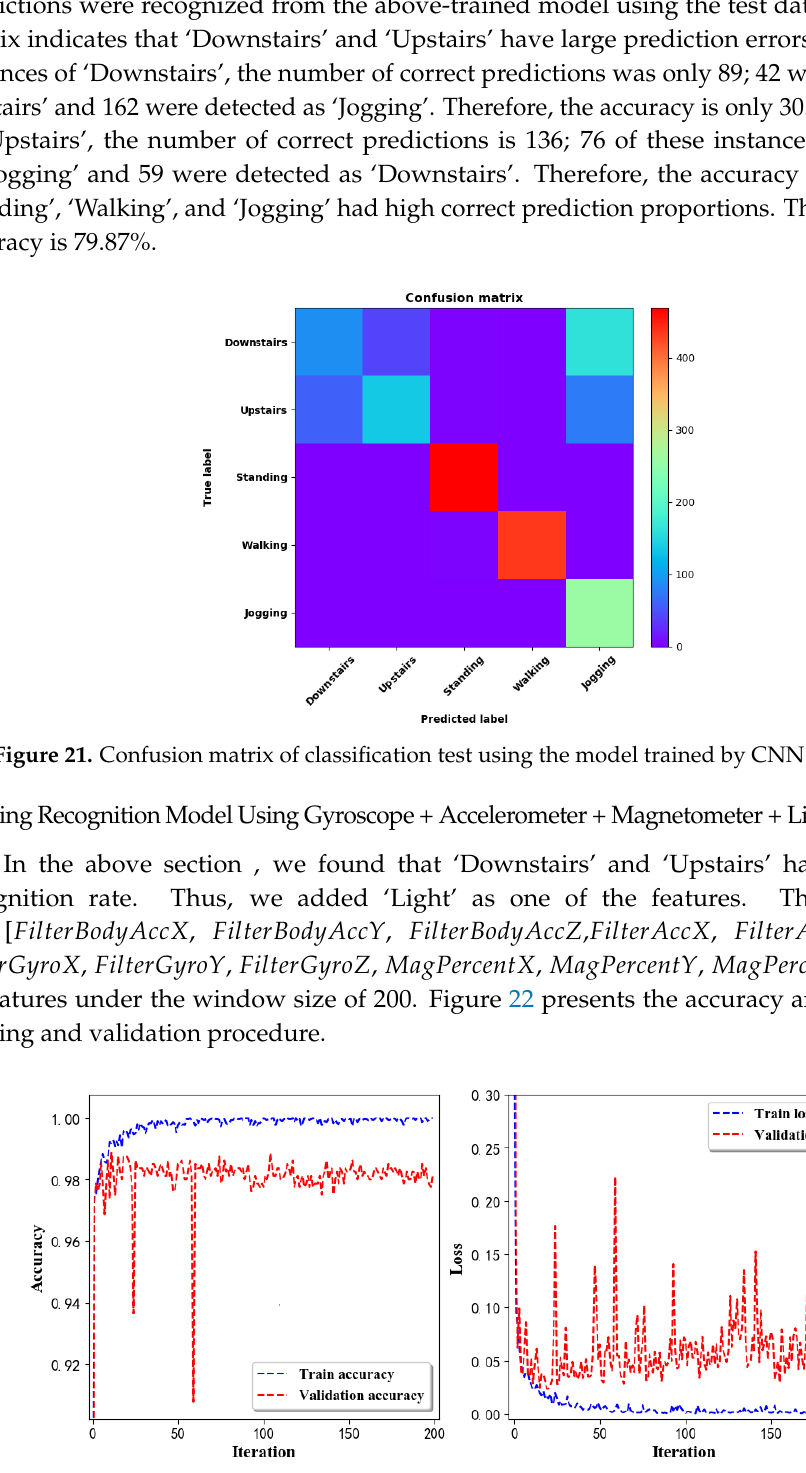
Figure 22. Accuracy ( left ) and loss ( right ) information of training and validation procedure with light